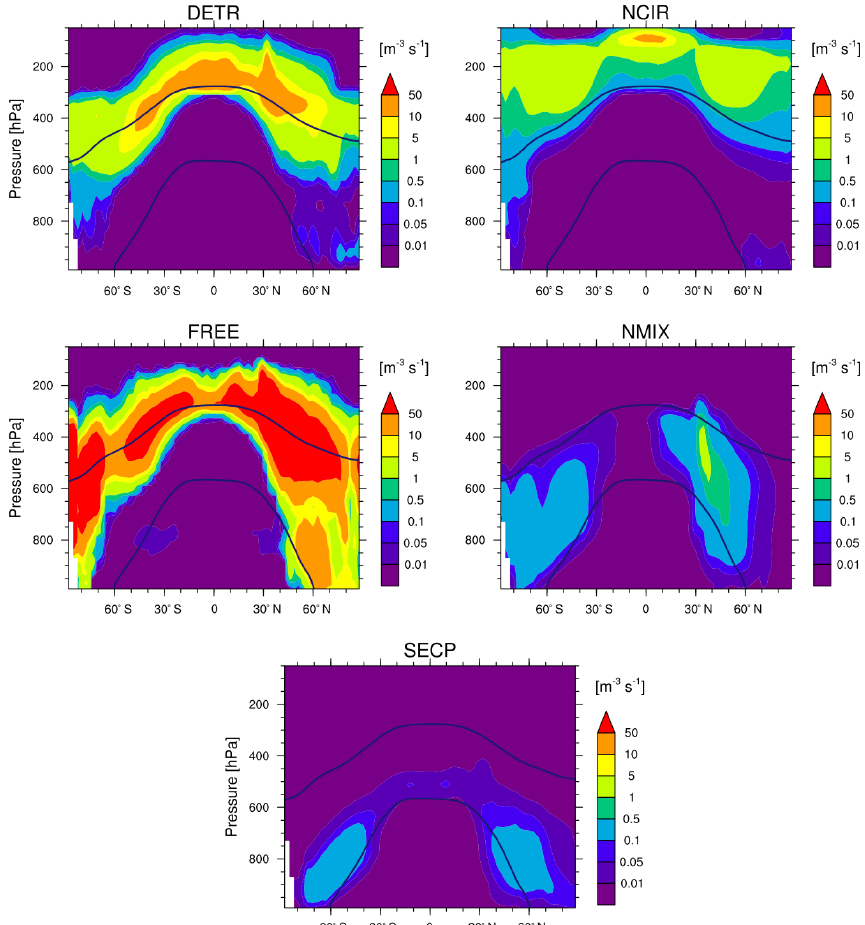
Figure 6. Annual zonal means of the tendencies associated with the IC sources in cold clouds (REF). The isotherms at 0 and − 35 ◦ C are annual